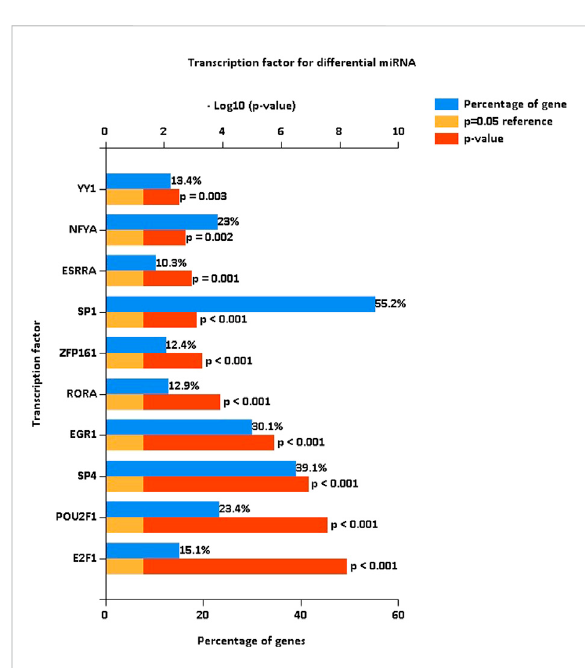
FIGURE 2 Transcription factor enrichment of differentially expressed miRNAs. Enrichment analysis of transcription factors, with the top 10 genes enriched for display. The blue bars are the proportion enriched, and the red bars indicate the p -values of the enrichment